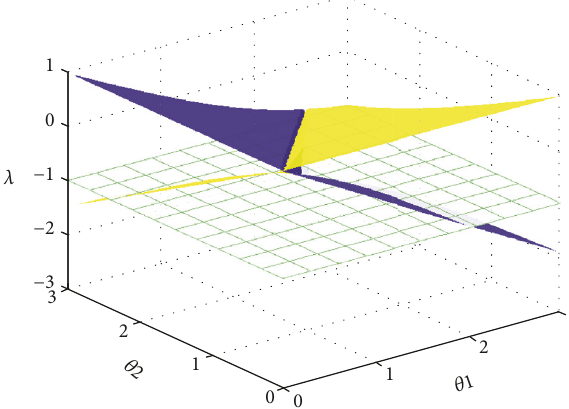
Figure 2: The characteristic root of system (14).